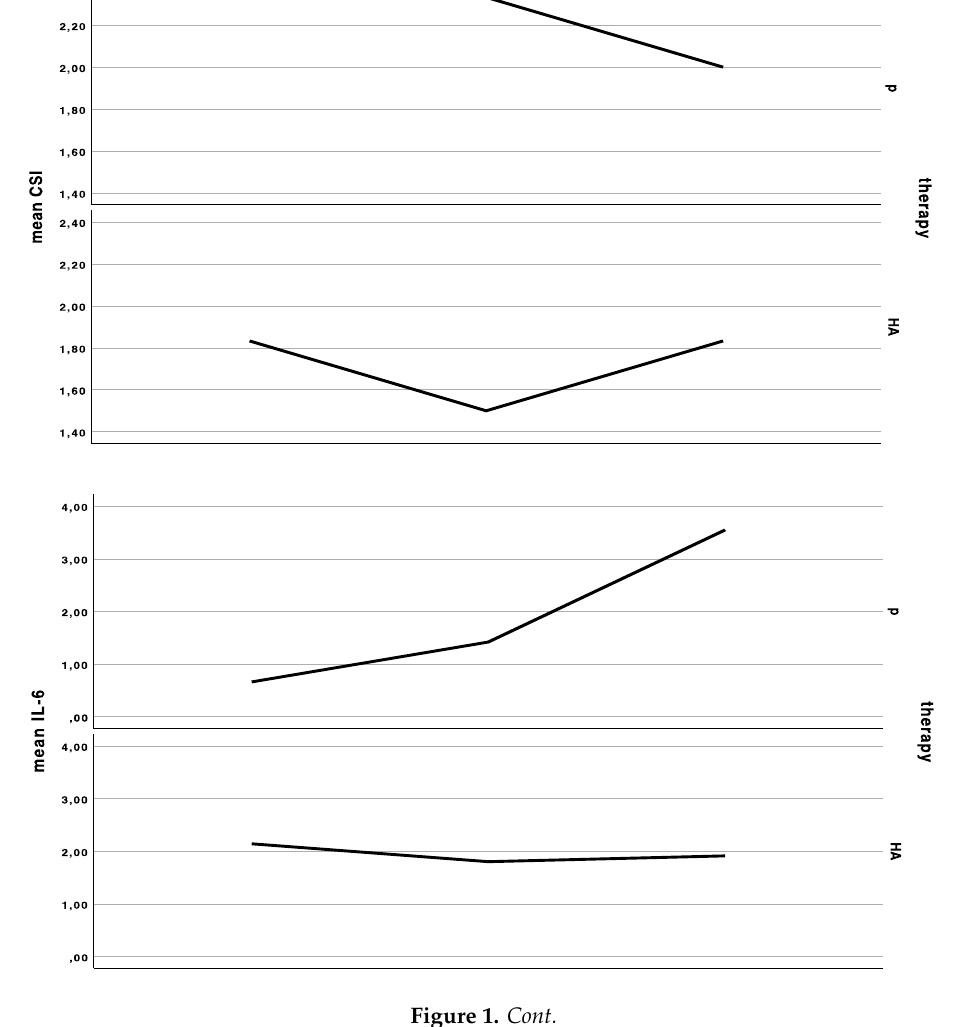
Figure 1. Curves indicating the mean clinical severity index (CSI), mean interleukin-6 (IL-6) levels in saliva, mean Oral Health Impact Profile (OHIP) summary score at the first baseline, cross-over, and last appointment in the group starting with placebo (p), and in the group starting with hyaluronic acid (HA), either for 6 weeks and a wash-out period of 48 h in between treatments. 3.3. Periodontal Microbiota